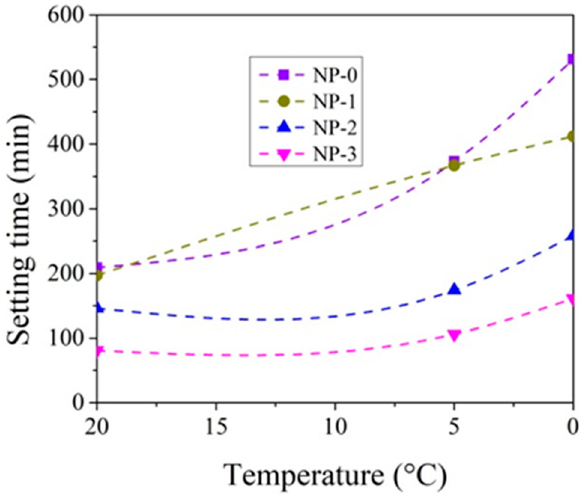
Figure 6. Final setting times of CEMIIN paste 0–3% with CN at different temperatures.